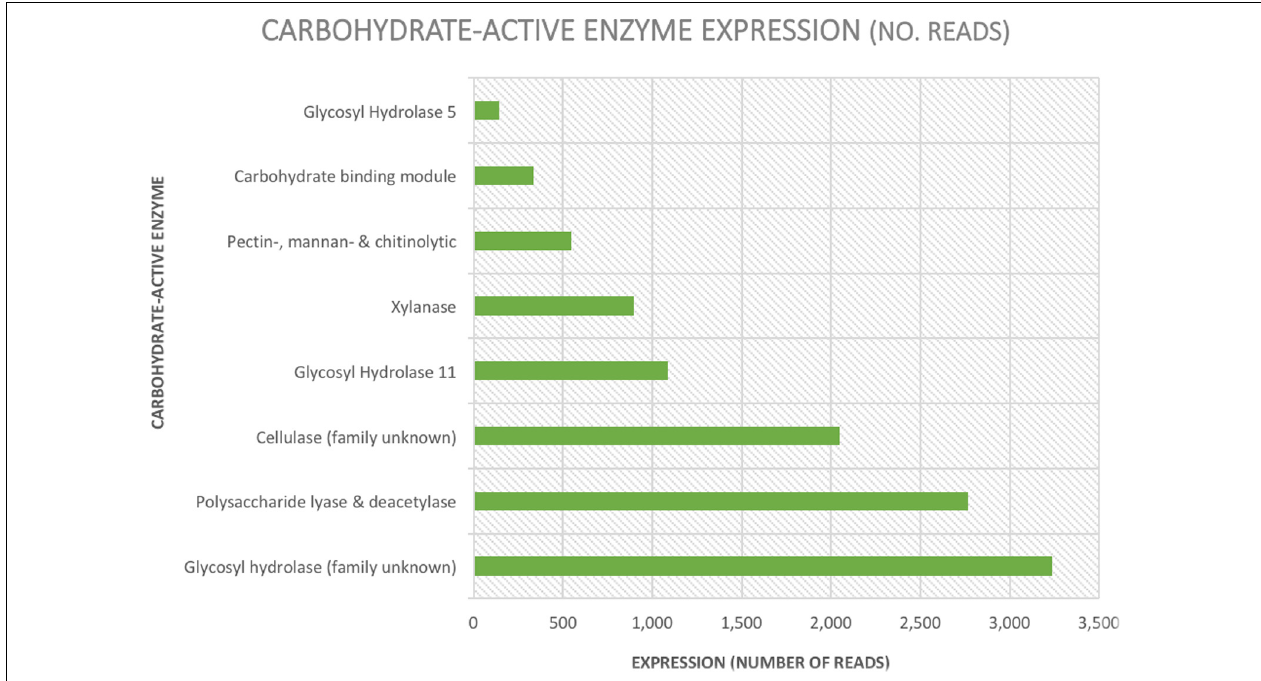
FIGURE 4 | Graphical representation of expression levels (number of reads) of carbohydrate-active enzymes annotated by EggNOG and confirmed using NCBI’s online Basic Local Alignment Search Tool.